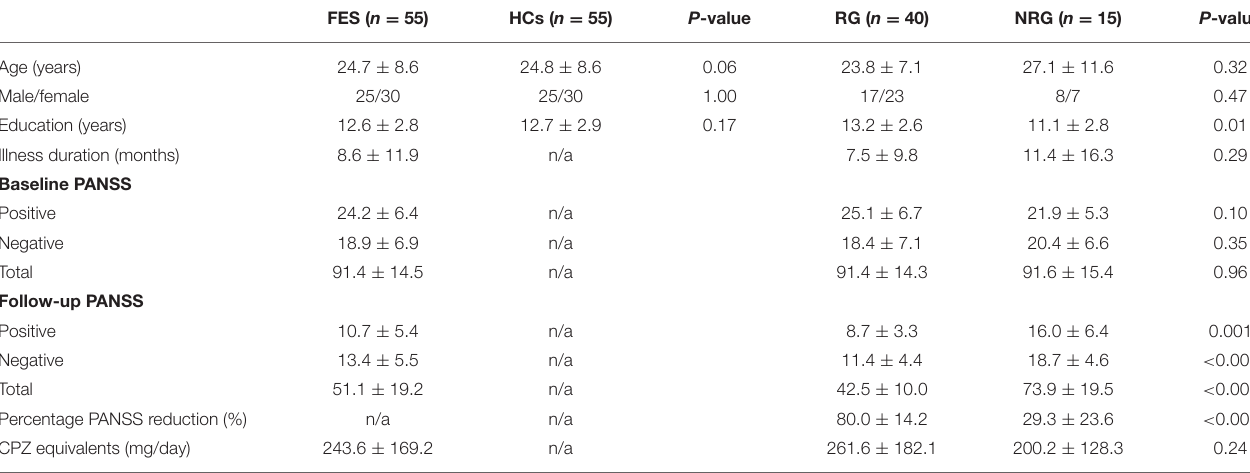
TABLE 2 | Demographic and clinical characteristics of participant groups.